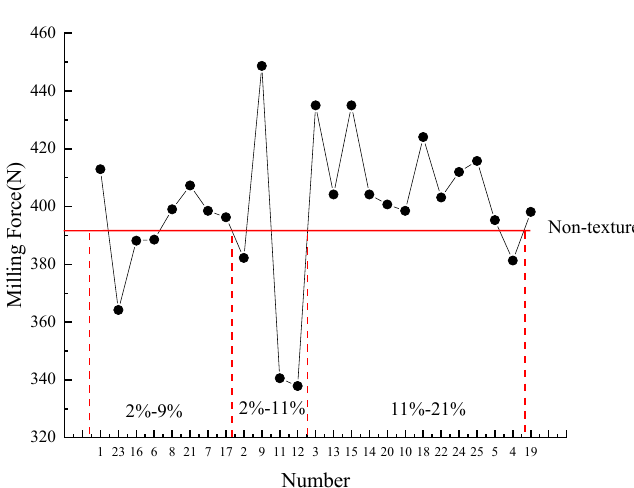
Figure 17. Proportion of micro-textured area in contact area of ball-end milling tool with chamfer tool edge.